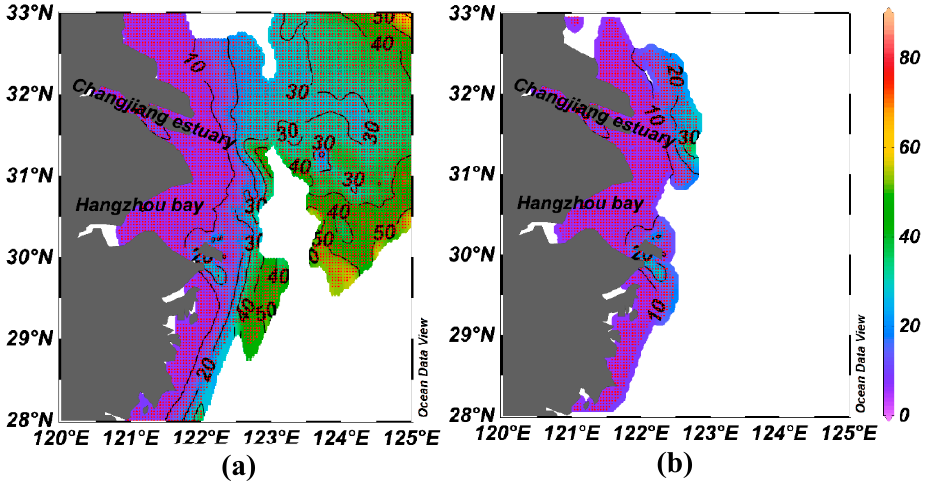
Figure 10. Distribution of the surface C / Chl- a > 200 ( a ) and overlapping area of C / N > 12 and C / Chl- a > 200 ( b ) in the Changjiang Estuary and adjacent ECS. The contours represent the isobaths.